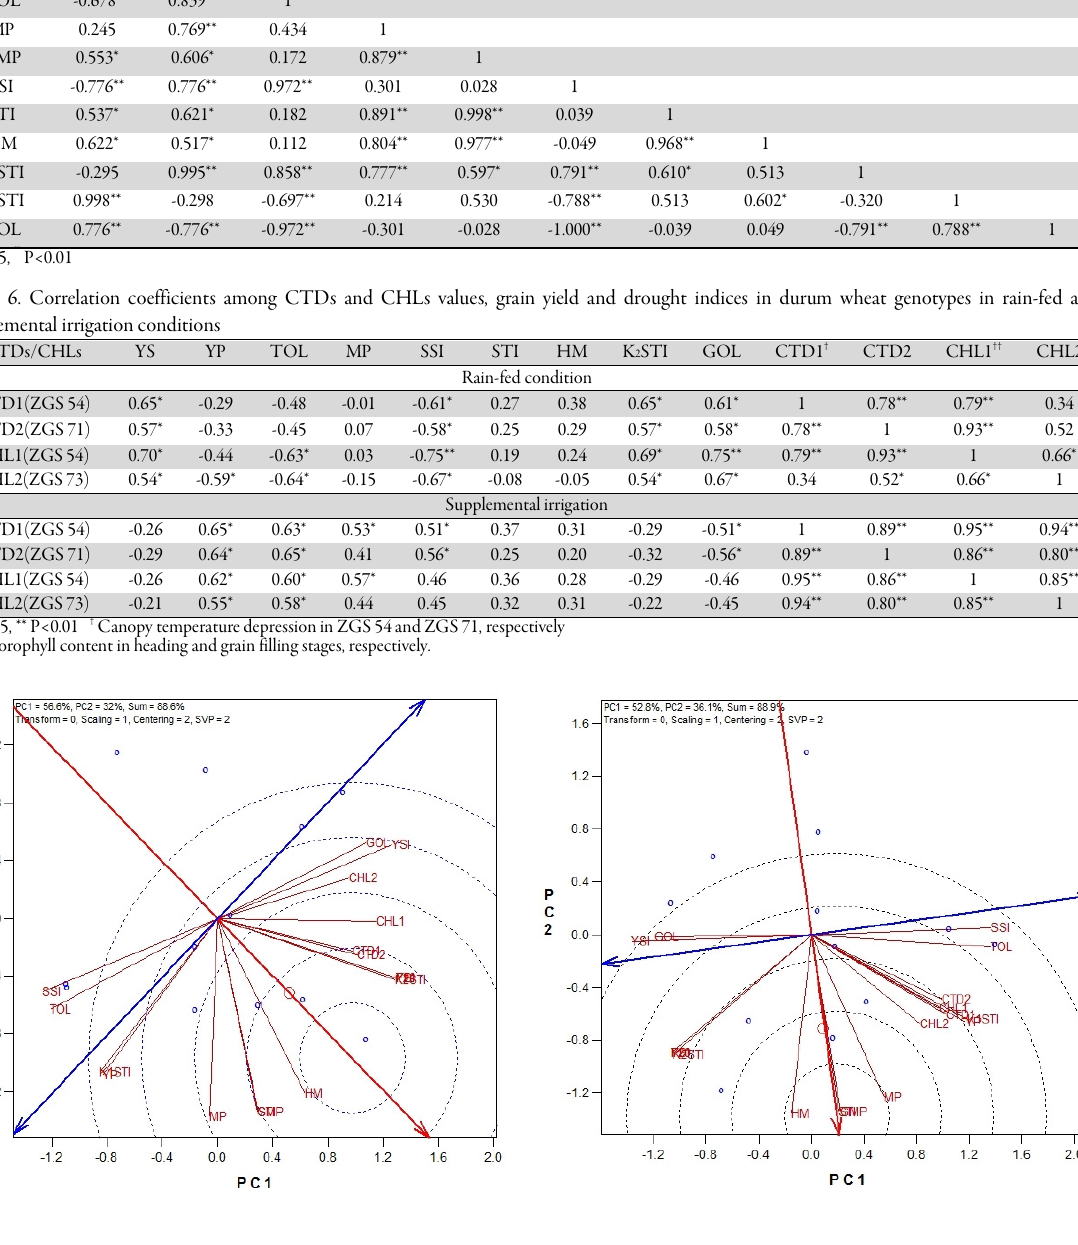
Fig. 1. Biplot of principal component analysis of physiological traits, grain yield and drought tolerance indices in rain-fed condition